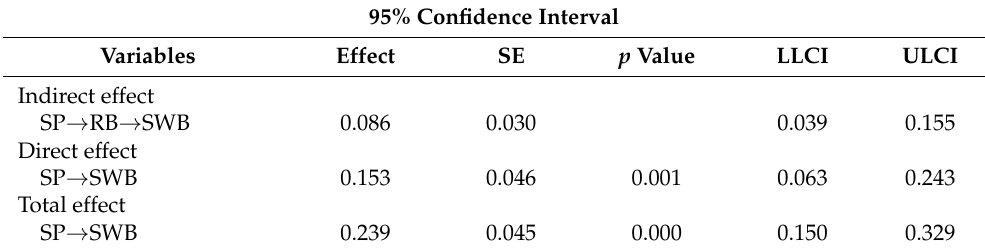
Table 6. Summary of mediating results of older men.